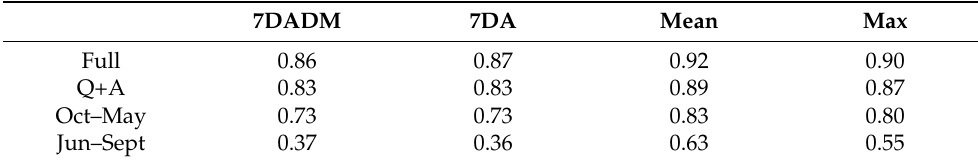
Figure 11. Comparison of modeled and observed temperatures (°C) for each scenario. The observed temperatures are plotted on the x-axis and the modeled temperatures are plotted on the y-axis. Scenarios shown are ( a ) 7DADM, ( b ) _Q+A, ( c ) 7DADM_Oct–May, ( d ) 7DADM_Jun–Sept, ( e ) 7DA, ( f ) 7DA_Q+A, ( g ) 7DA_Oct–May, ( h ) 7DA_Jun–Sept, ( i ) max, ( j ) max_Q+A, ( k ) max_Oct–May, ( l ) max_Jun–Sept, ( m ) mean, ( n ) mean_Q+A, ( o ) mean_Oct–May, and ( p ) mean_Jun–Sept. Table 5. R 2 for each scenario. “Full” refers to those scenarios that used all annual data and environ- mental